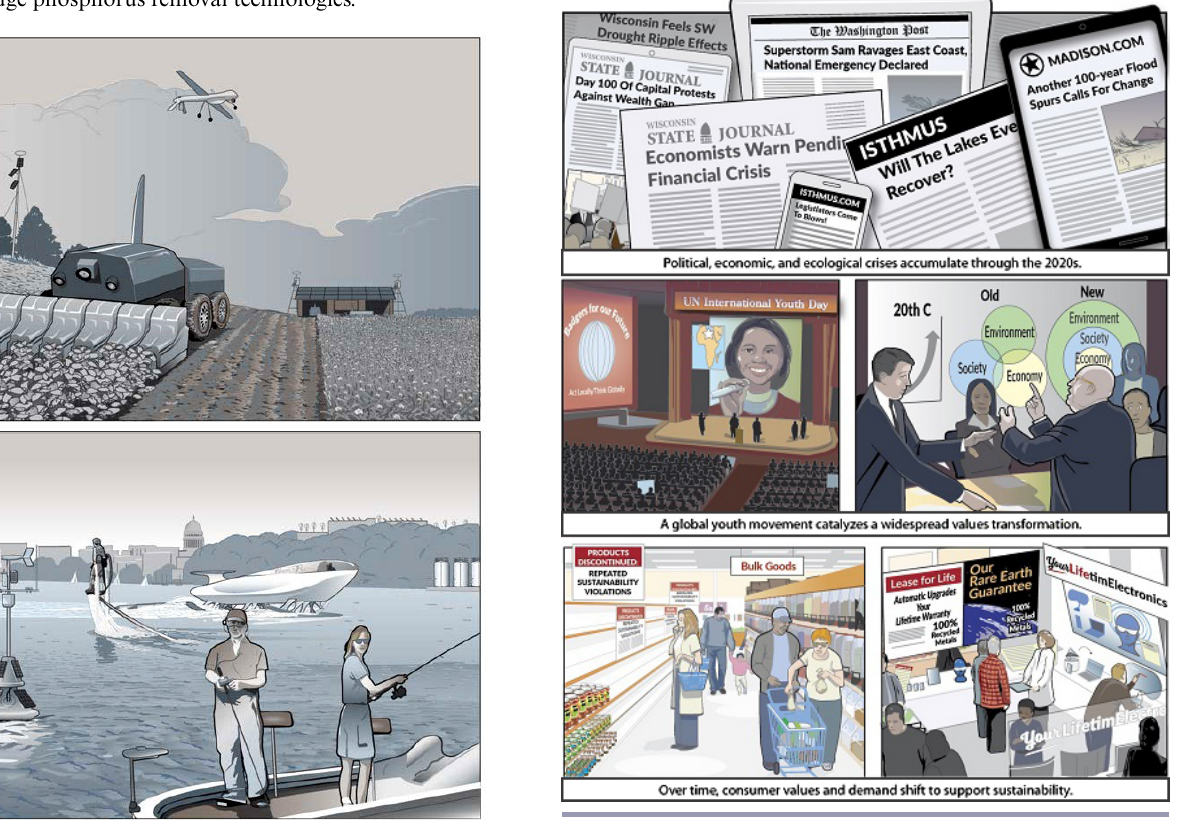
Fig. 6. During the “Accelerated innovation” scenario, agriculture and water quality management are revolutionized genetic engineering, laboratory-generated artificial meat, and cutting-edge phosphorus removal technologies.